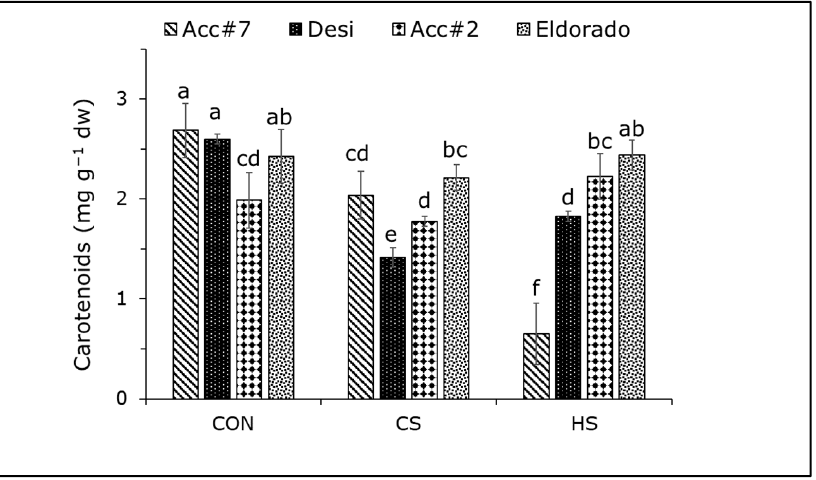
Figure 4. Carotenoids in the second fully expanded top leaves of four chickpea genotypes under the treatments for 3 days. "CON", 25/20 °C day/night; "CS", 8/4 °C day/night; "HS", 38/33 °C day/night. The data represent average values ± SD ( n = 3). Different small letters above the bars indicate significant differences ( p < 0.05).